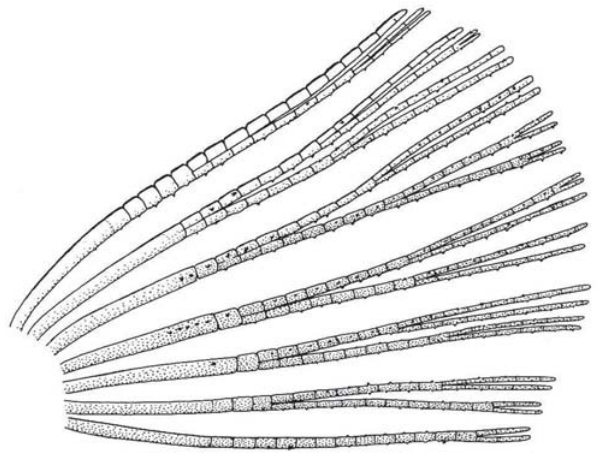
Fig. 66. Mimagoniates sylvicola , adult male, USNM 276557, 29.3 mm SL; pelvic-fin rays of adult male, ventral view, left side, anterior at left. Modified from Menezes & Weitzman